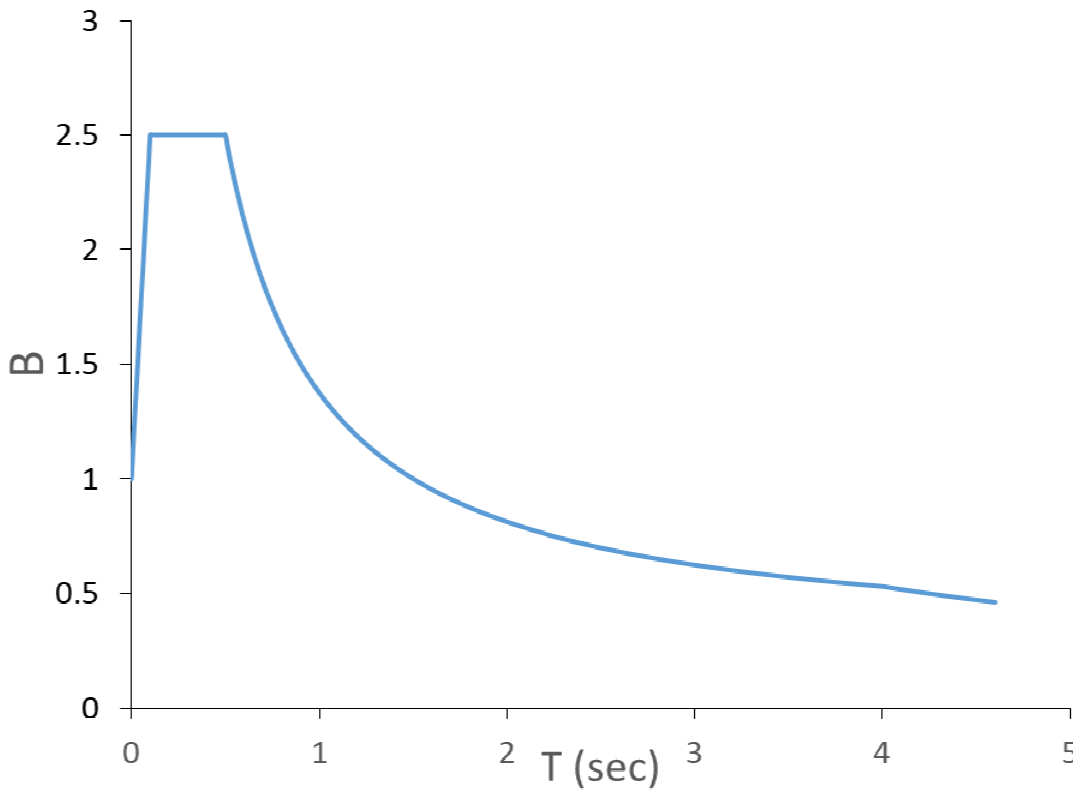
Figure 4. Response spectra intended for dynamic analysis (Iranian seismic code, 2015).